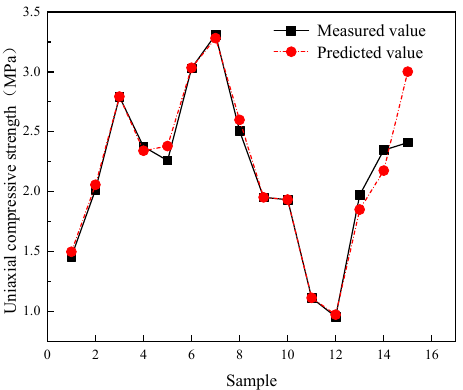
Figure 22. Comparison of measured values and predicted values. Table 4. Prediction results of strength at different temperatures.